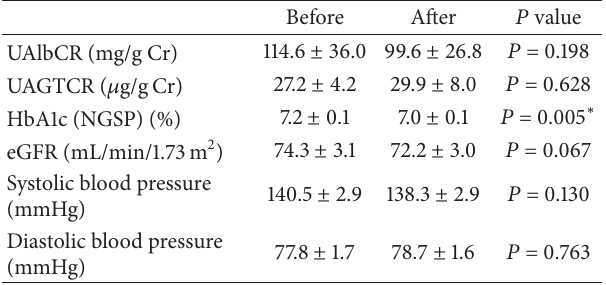
Table 2: Laboratory data of before and after treatment by